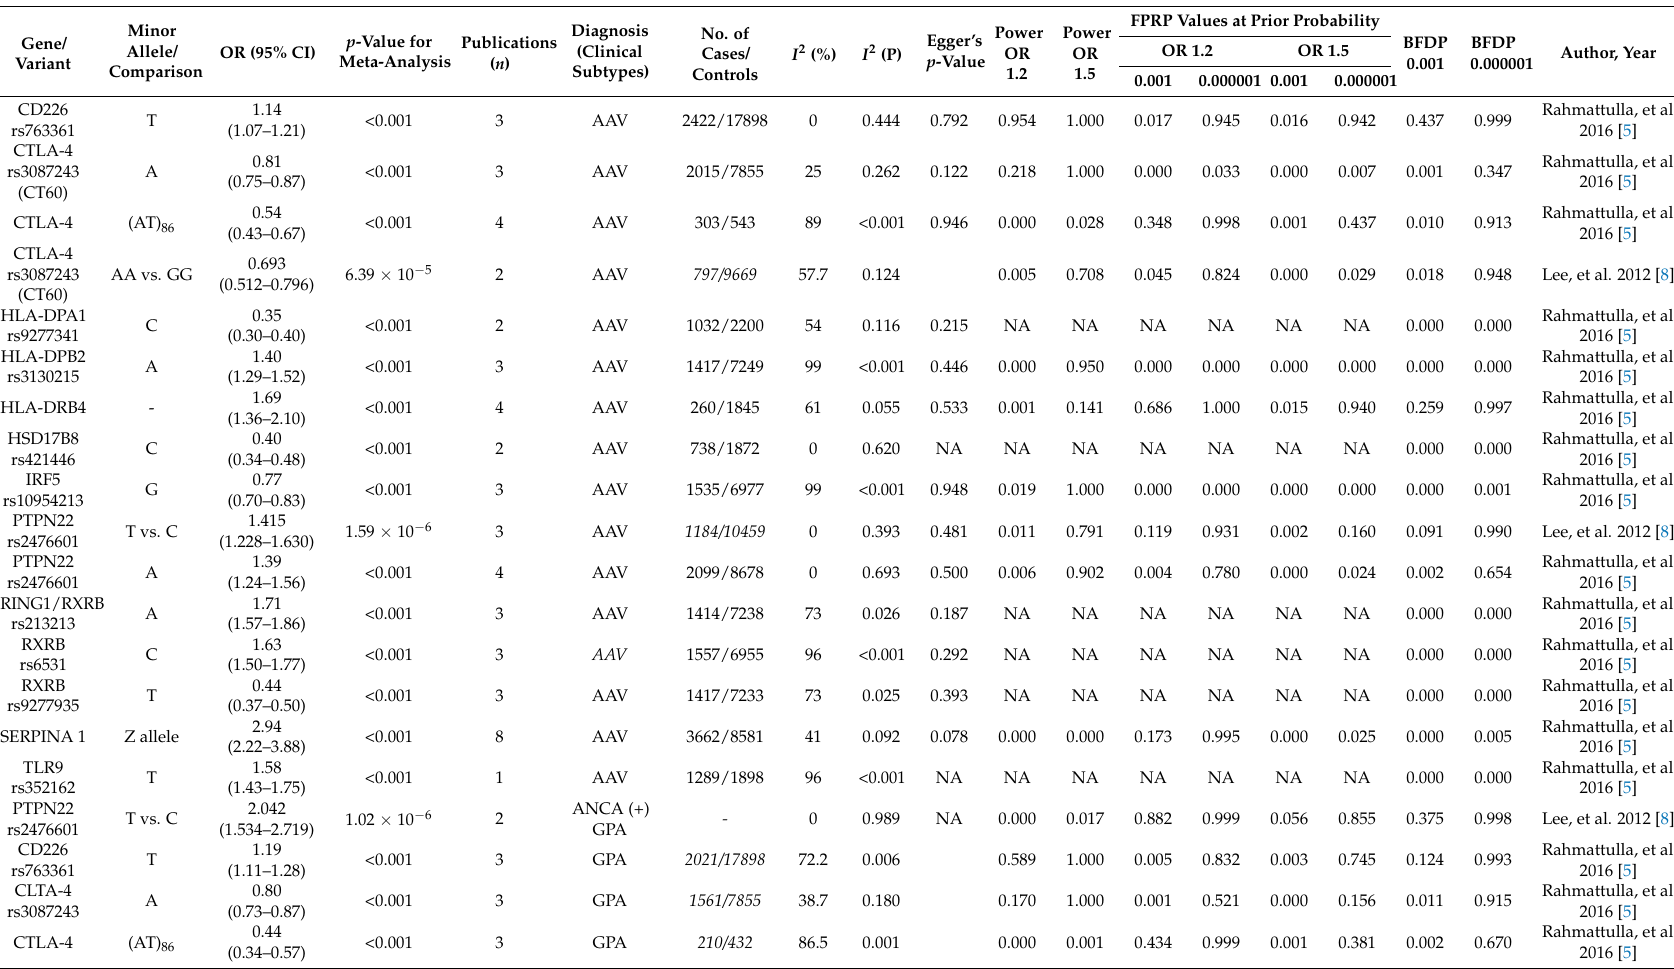
Table 1. Meta-analysis results of observational studies; gene variants with statistical significance ( p -value < 0.05), found to be noteworthy by false-positive report probability (FPRP) or Bayesian false discovery probability (BFDP) for each clinical diagnosis antineutrophil cytoplasmic antibody (ANCA)-associated vasculitis (AAV), granulomatosis with polyangiitis (GPA), and microscopic polyangiitis